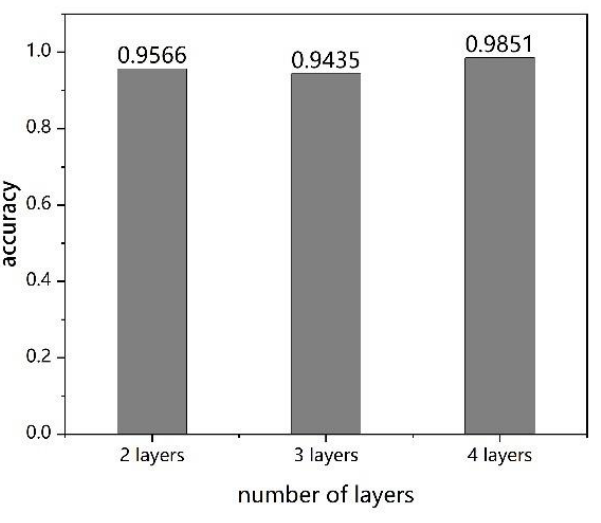
Figure 8. Accuracy of different numbers of layers of LSTM in the test dataset.